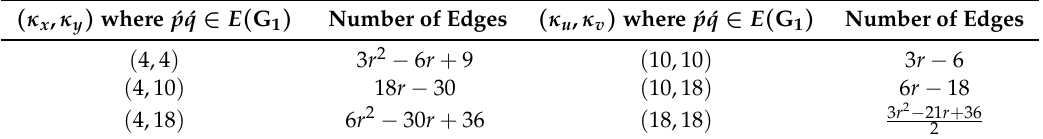
Table 2. Edge partition of a hex-derived network of type 3 HDN 3 ( r ) based on degrees of end vertices of each